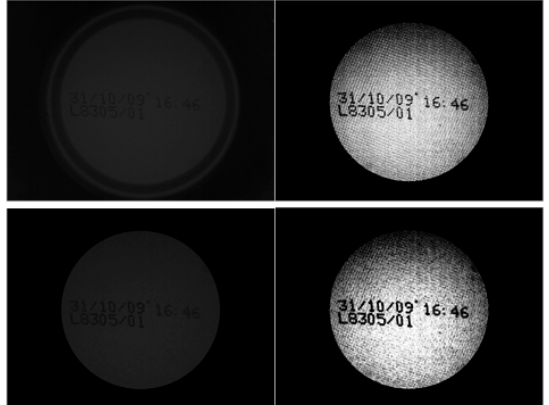
Figure 11. ( Top left ): original image. Top right: original image equalised; ( Bottom left ): original image enhanced; ( Bottom right ): original image enhanced and then equalised.